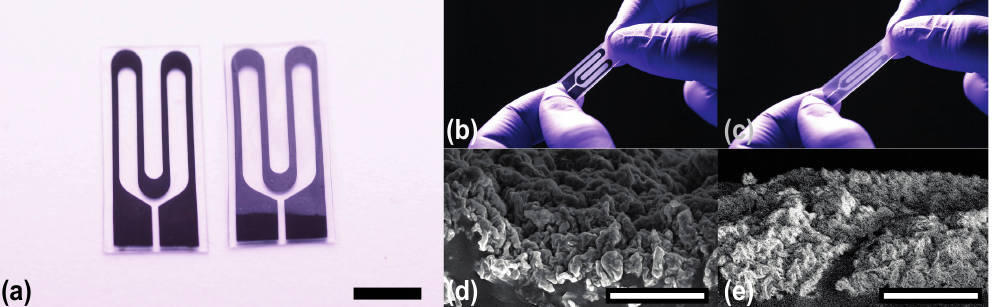
Figure 1. ( a ) Fabricated unencapsulated and encapsulated sensors prior to characterization. Scale bar is 5 mm. ( b ) Unencapsulated sensor unstrained (0% strain). ( c ) Unencapsulated sensor strained roughly to 50% strain. ( d ) Scanning electron microscope (SEM) image of the wrinkle features unstrained (0% strain) (taken with secondary electrons) and ( e ) strained (50% strain) (taken with backscattered electrons). Scale bar in SEM images is 10 μ m.